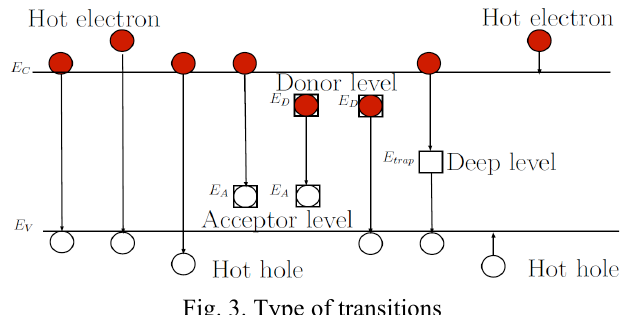
Fig. 3. Type of transitions